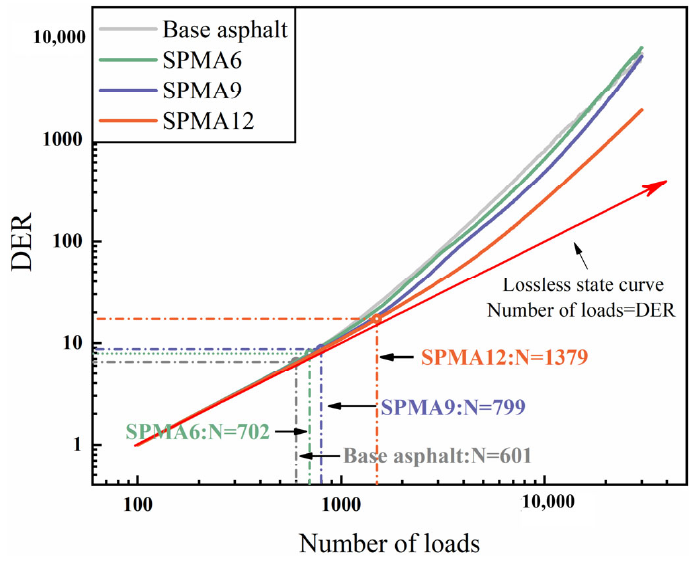
Figure 19. DER curve of asphalt binders.